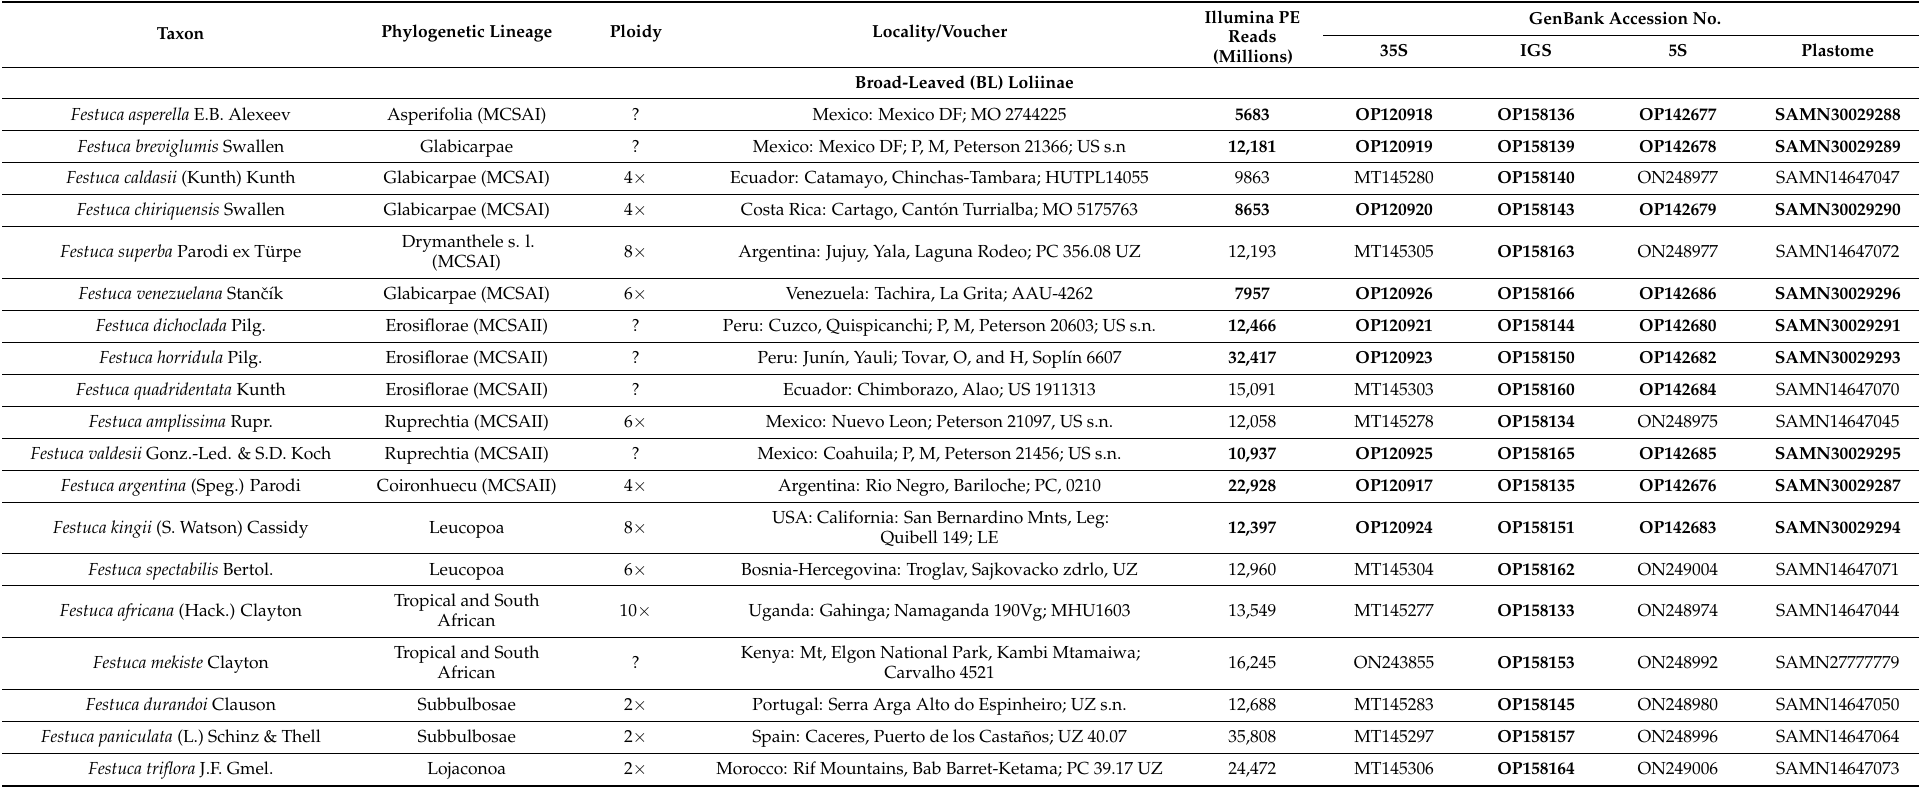
Table 2. Taxa included in the phylogenomic analysis of Mesoamerican and South American polyploid broad-leaved Festuca grasses. Taxon name and authorship, Loliinae phylogenetic lineage, ploidy level, locality of collection and voucher information, number of genomic Illumina pair-end read sequences, and GenBank accession codes for nuclear rDNA 35S cistron, (45S) IGS and 5S gene regions, and plastome sequences are given for each sample. Values in bold correspond to new data generated in this study. Ploidy levels are based on chromosome counts from previous studies (all Festuca species show the same chromosome base number